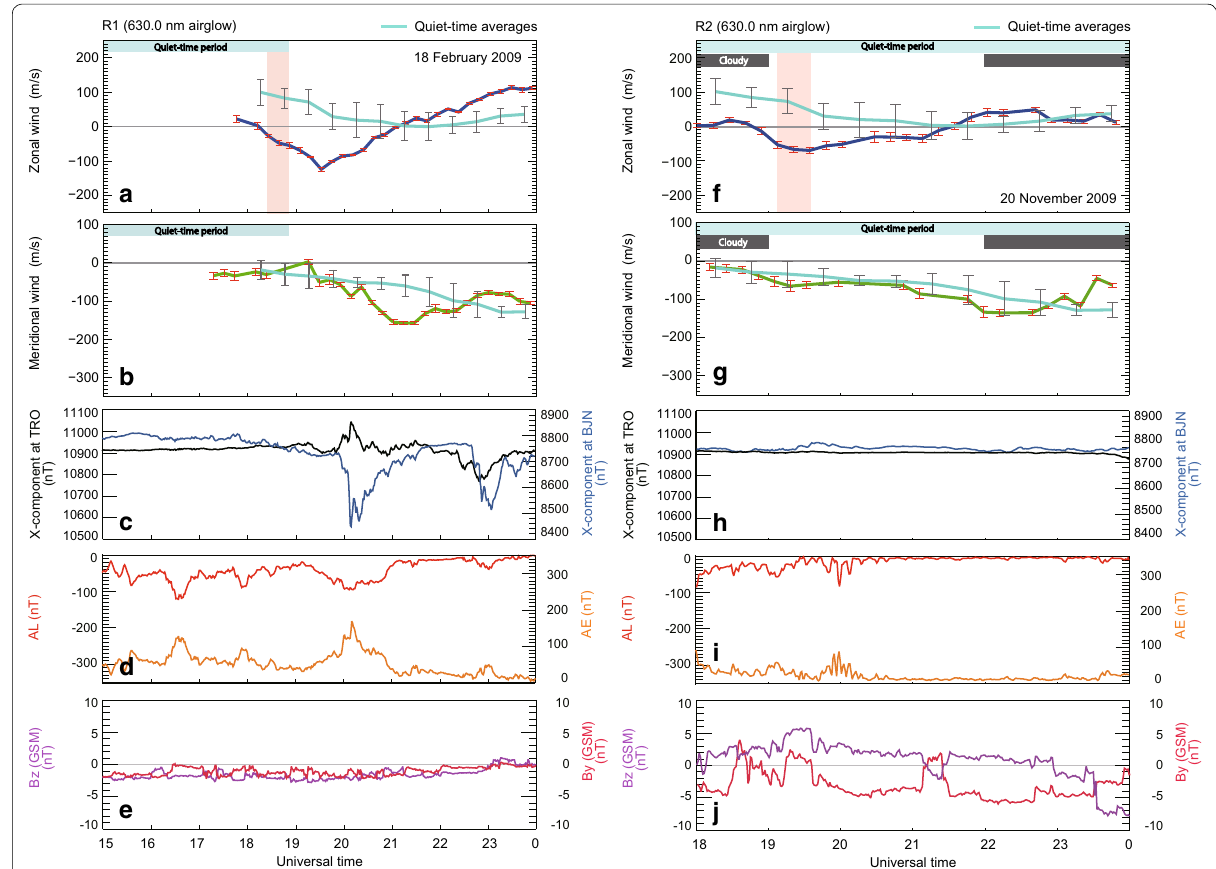
Fig. 3 Two thermospheric wind measurements (events R1 and R2) during quiet times, whose zonal wind showed large deviation (> 100 m/s) from quiet‑time average. a , f Zonal wind. b , g Meridional wind. c , h X component of magnetometer data at Tromsø and Bear Island. d , i AE and AL indices. e , j IMF By and Bz in GSM coordinates. The blue rectangle indicates the quiet‑time period, namely Kp auroral activity being identified above Tromsø. The red rectangle indicates the interval of the deviated measurements. The light blue curve indicates the quiet‑time average wind, and the dark‑gray rectangles indicate times of